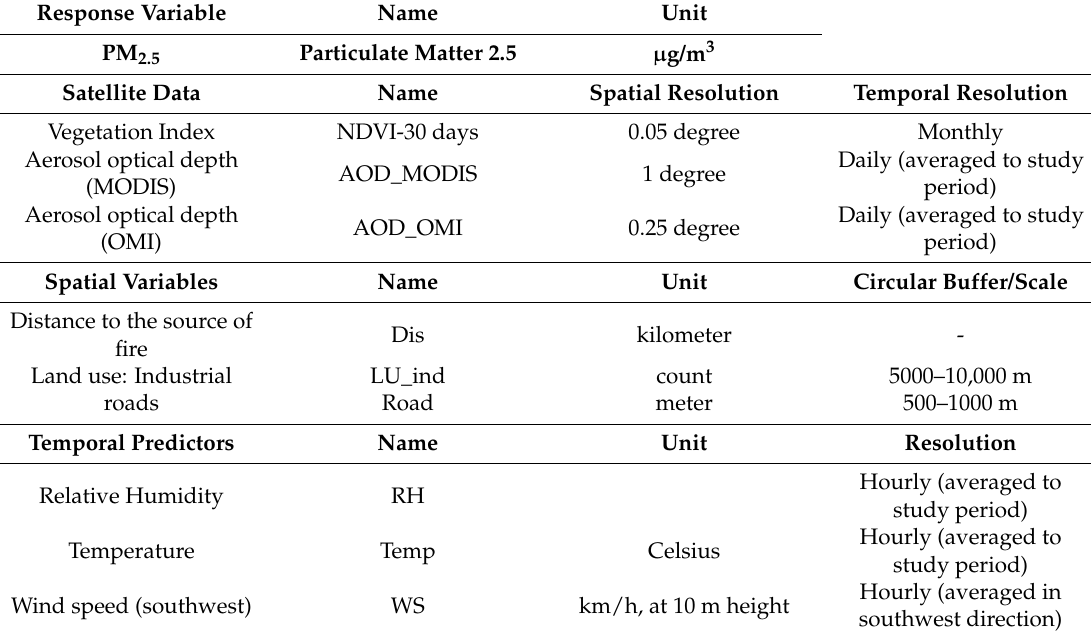
Table 1. Response (PM 2.5 ) and predictor variables including satellite data, spatial and temporal variables used in variable selection procedure.